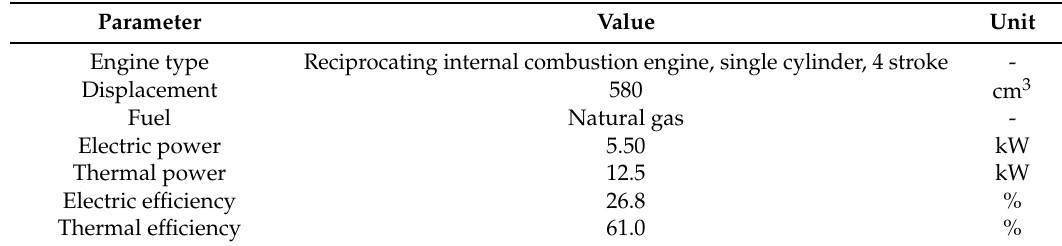
Table 5. Rated micro ‐ CHP parameters.